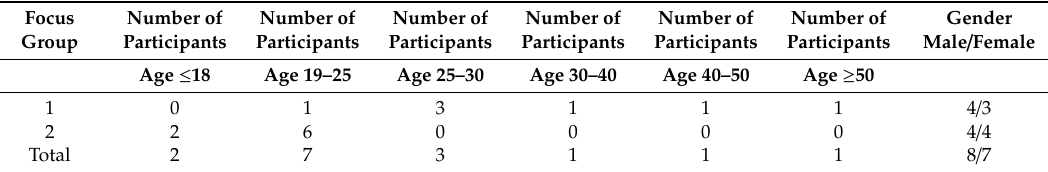
Table 2. Summary of the characteristics of focus group